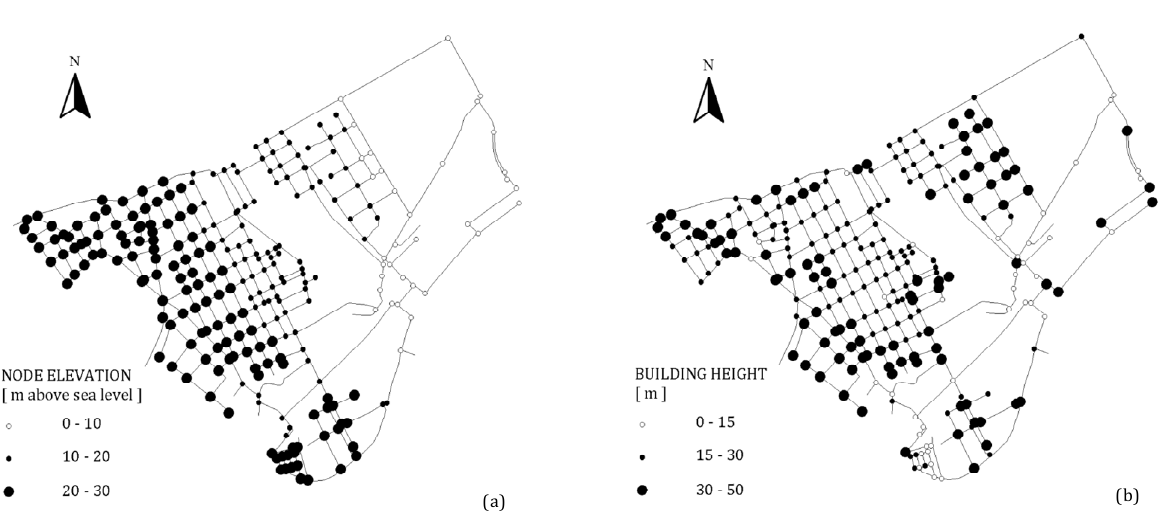
Figure 5. ( a ) A map of the network node elevation; ( b ) A map of the corresponding average building